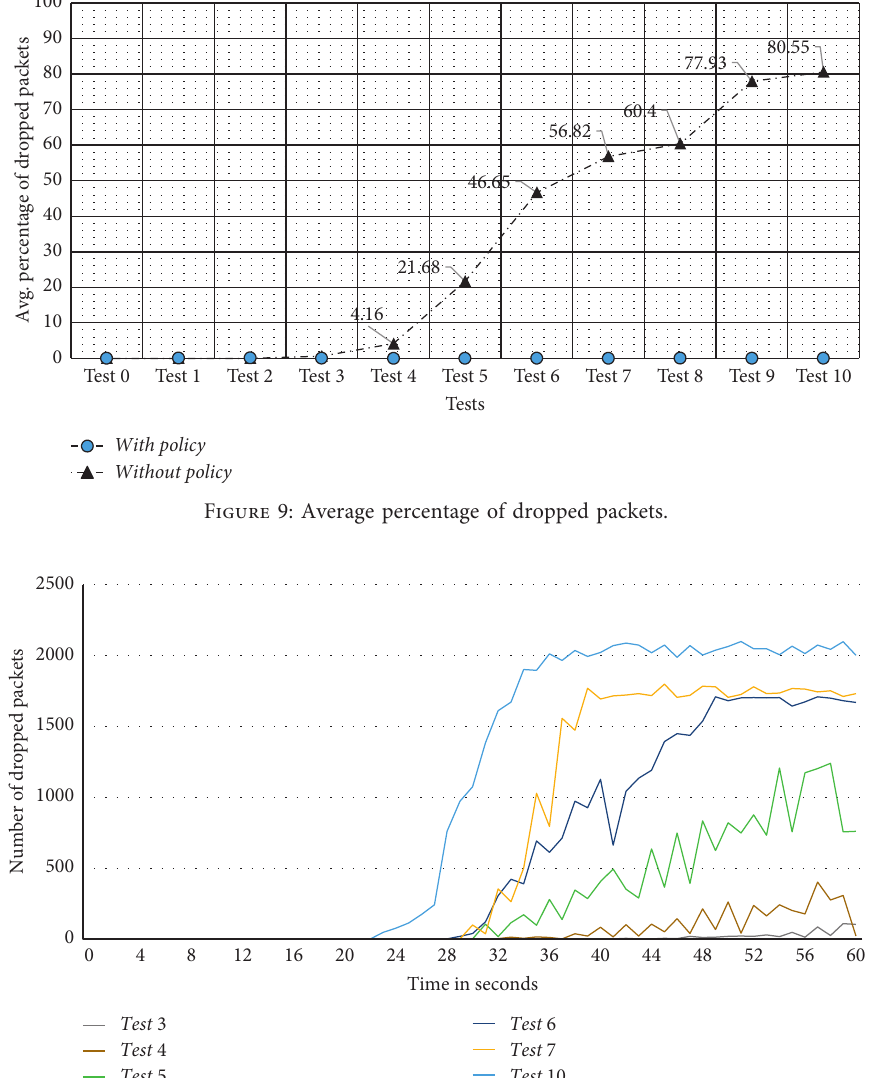
Figure 10: Number of dropped packets by the kernel without